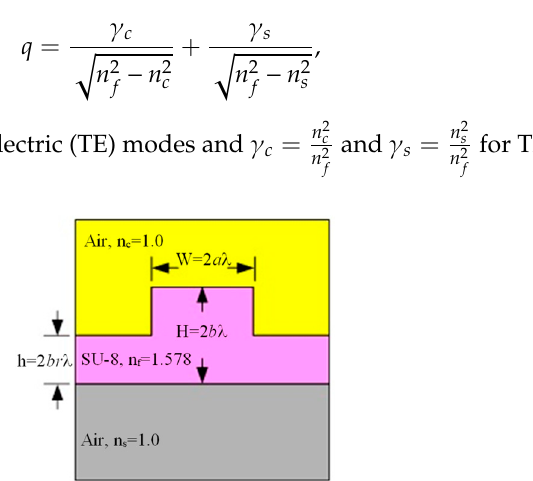
Figure 9. Cross section of the waveguide structure showing the geometric parameters and optical properties of the materials in each layer.